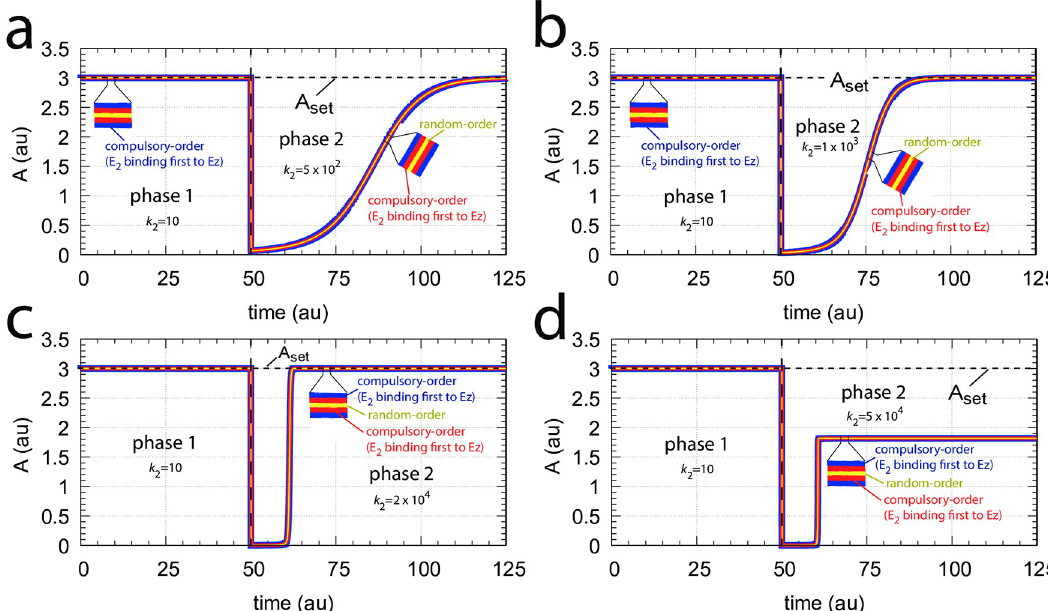
Fig 25. Comparison between the three m4-controllers when E 1 and E 2 are removed by enzymatic ternary-complex mechanisms (Figs 19 and 24) upon step-wise changes at time t = 50 from k 2 =10 to (a) k 2 =500, (b) k 2 =1 × 10 3 , (c) k 2 =2 × 10 4 , (d) k 2 =5 × 10 4 . Color coding: Thick blue line, compulsory-order mechanism with E 2 binding first to Ez ; overlaid red line, compulsory-order mechanism with E 1 binding first to Ez ; top overlaid yellow line, random-order mechanism. Rate constants and initial concentrations as for the random-order ternary-complex mechanism (Fig 20).